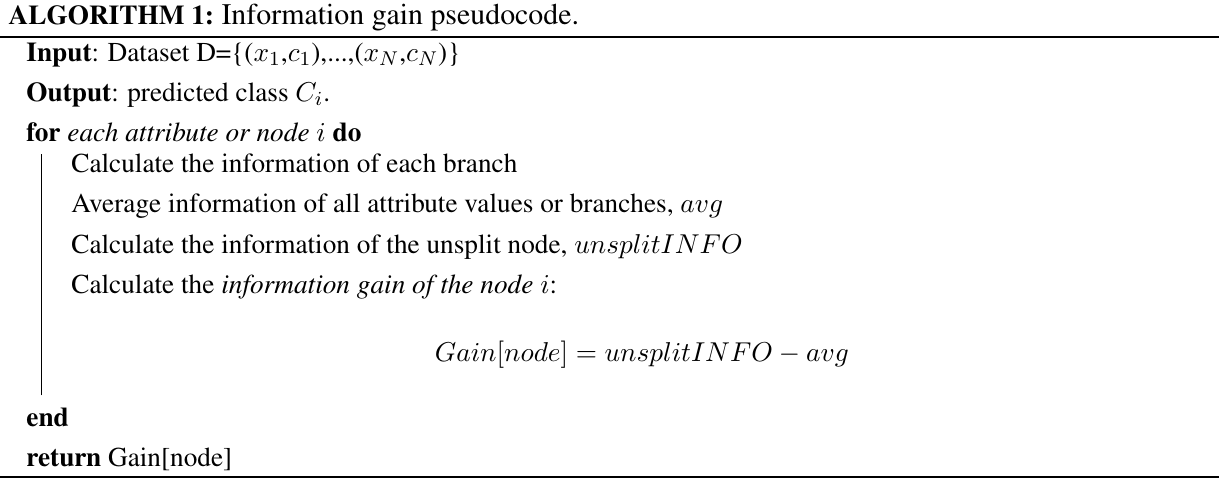
ALGORITHM 1: Information gain